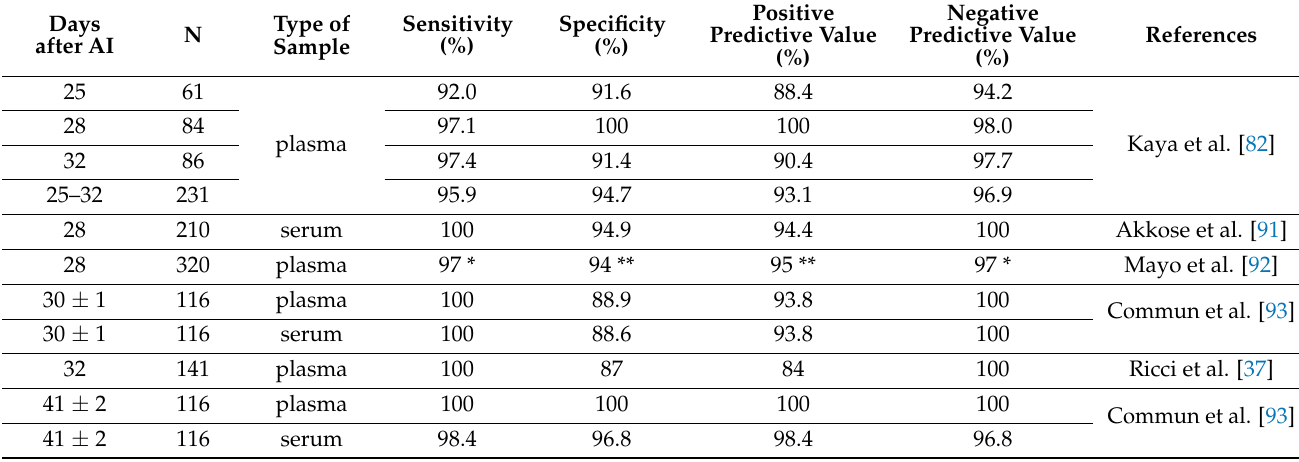
Table 7. Accuracy of commercially available IDEXX bovine pregnancy ELISA tests for diagnosing early pregnancy in dairy cattle.